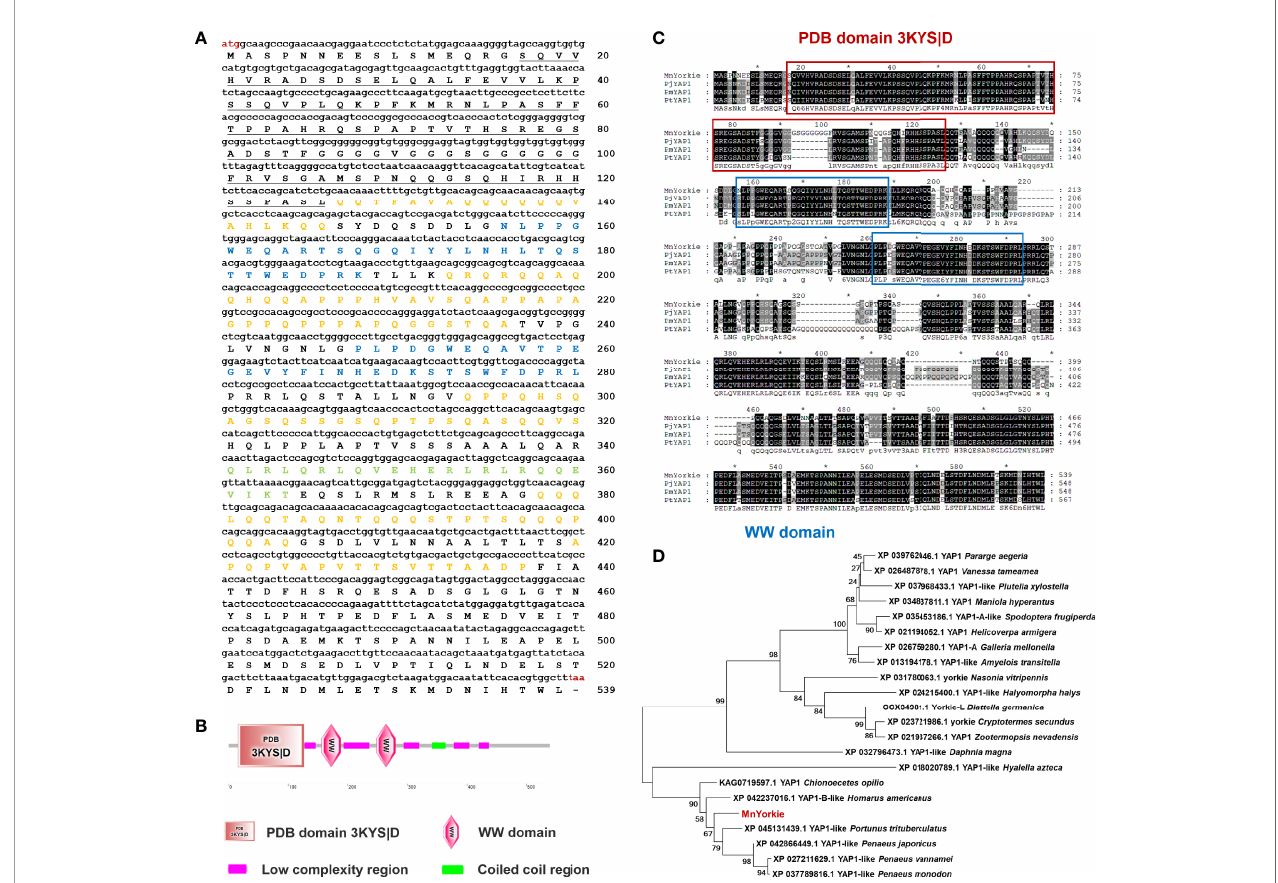
FIGURE 1 | (A) Nucleotide (upper case) and deduced amino acid (lower case) sequence of MnYorkie from M. nipponense. The sequences were shown and numbered along the right margin. The red letters indicated the start codon (ATG) and the stop codon (TAA). The PDB domain 3KYS|D was underlined. Two WW domains were shown in blue. The coiled coil region and fi ve low complexity regions were marked in green and orange, respectively. (B) Domain organization of MnYorkie predicted by SMART. (C) Multiple-sequence alignment of MnYorkie with other crustacean YAPs. The identical amino acid residues were shaded in black and the similar residues in gray. The sequences used for the multiple sequence alignment included PjYAP1 from P. japonicus (XP_042866449.1); PmYAP1 from P. monodon (XP_037789816.1) and PtYAP1 from P. trituberculatus (XP_045131439.1). (D) Phylogenetic tree of YAPs. The alignment was created using MEGA 7.0 based on the amino acid sequences of 21 YAP family members from different organisms. The phylogenetic tree was built by the NJ algorithm, and the numbers at the nodes indicated the bootstrap value. MnYorkie was shown in